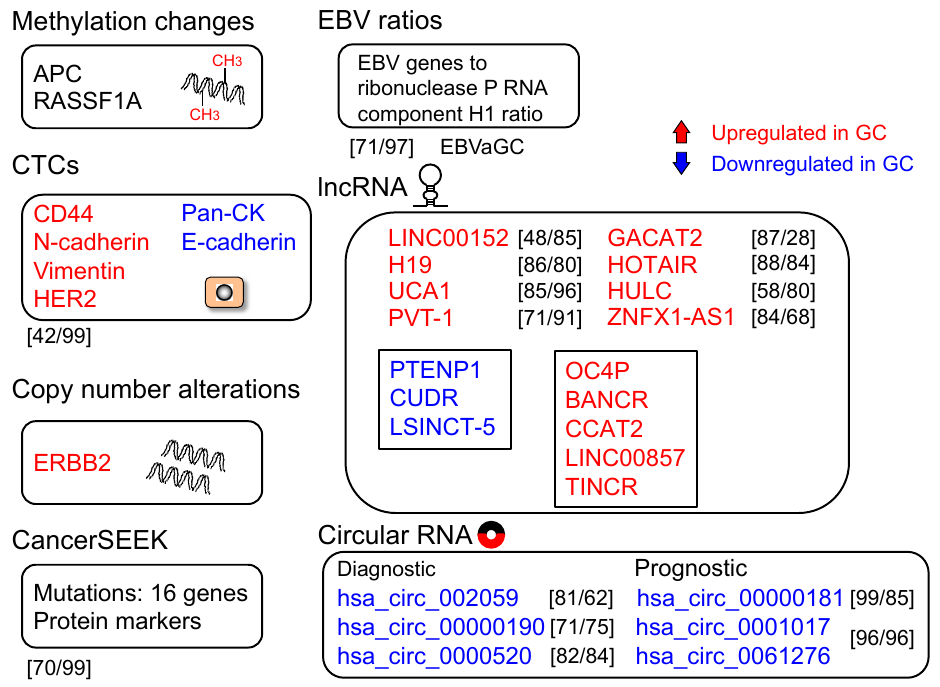
Figure 2. Molecular targets with the potential as diagnostic biomarkers for gastric cancer (GC). Upregulated (in red) and downregulated (in blue) markers are shown. Sensitivity and specificity are shown in square brackets.